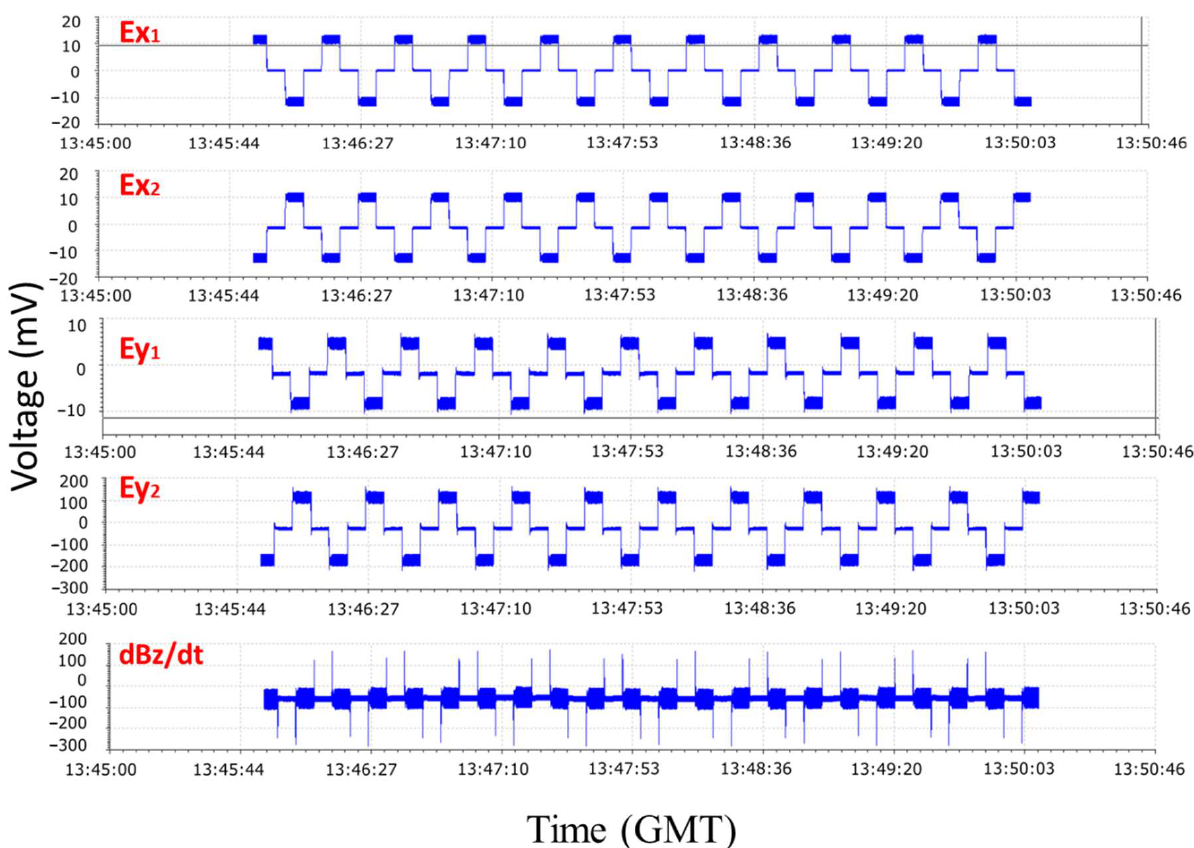
Figure 5. Data visualization in KMSProQA of the time-series (Ex1, Ex2, Ey1, Ey2, and airloop, Hz) from ST-03 measuring FSEM 50% duty cycle data at 1 kHz sampling rate. The setup shown here is the CSEM setup with four electric fields.